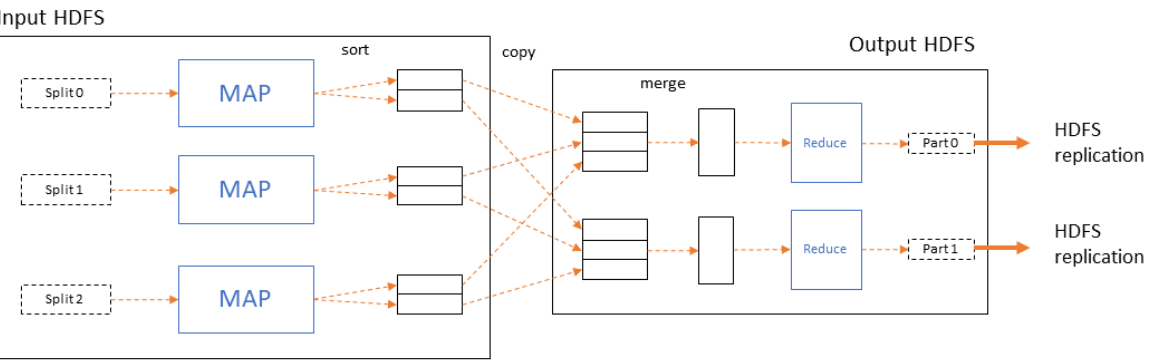
Figure 7. The Reduce function applied in parallel for each group created by the Map () function.